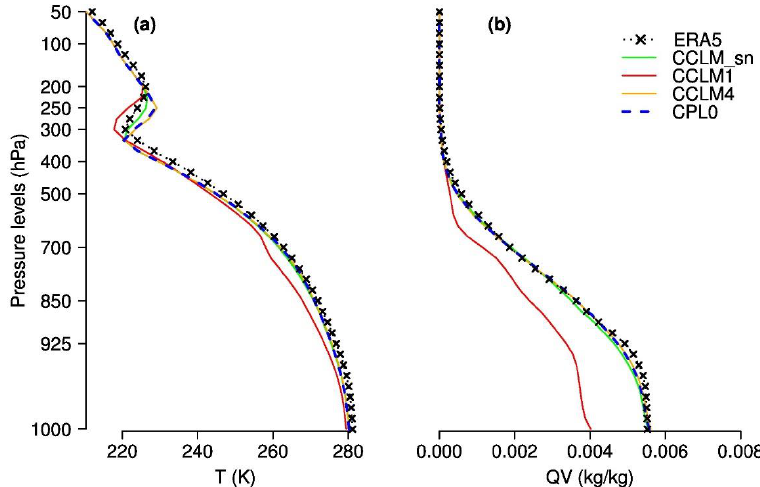
Figure 8. Profiles of daily mean ( a ) air temperature T (K) and ( b ) specific humidity QV (kg / kg) averaged over the NwgSea area on 28 October 2013.